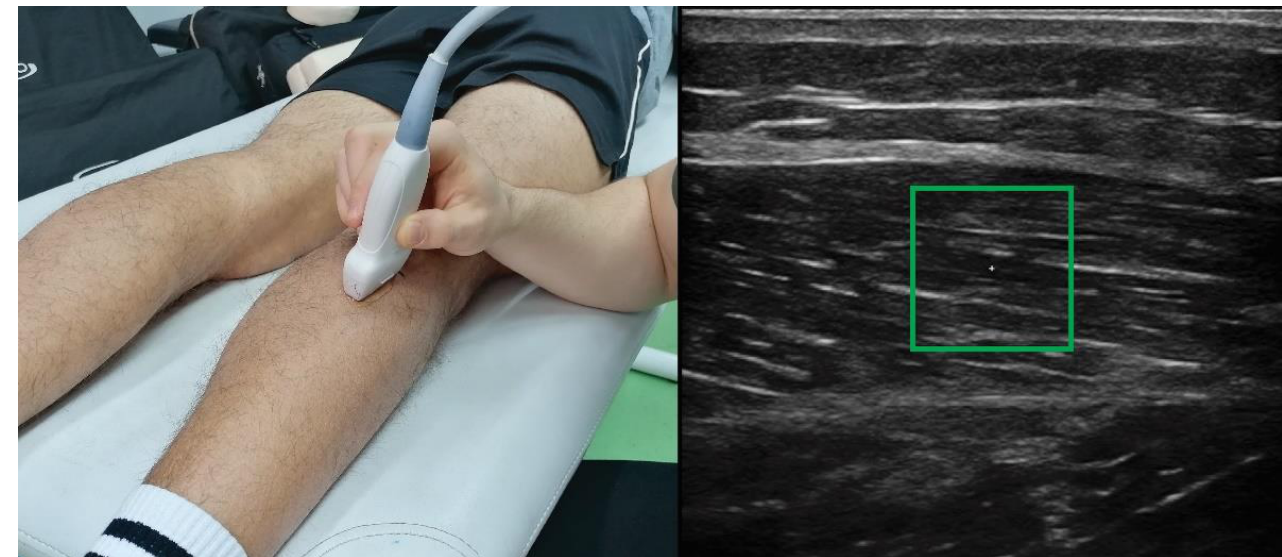
Figure 1. An example of shear-wave elastography use on gastrocnemius muscle. The green box represents the region of interest for which the shear modulus is analyzed.